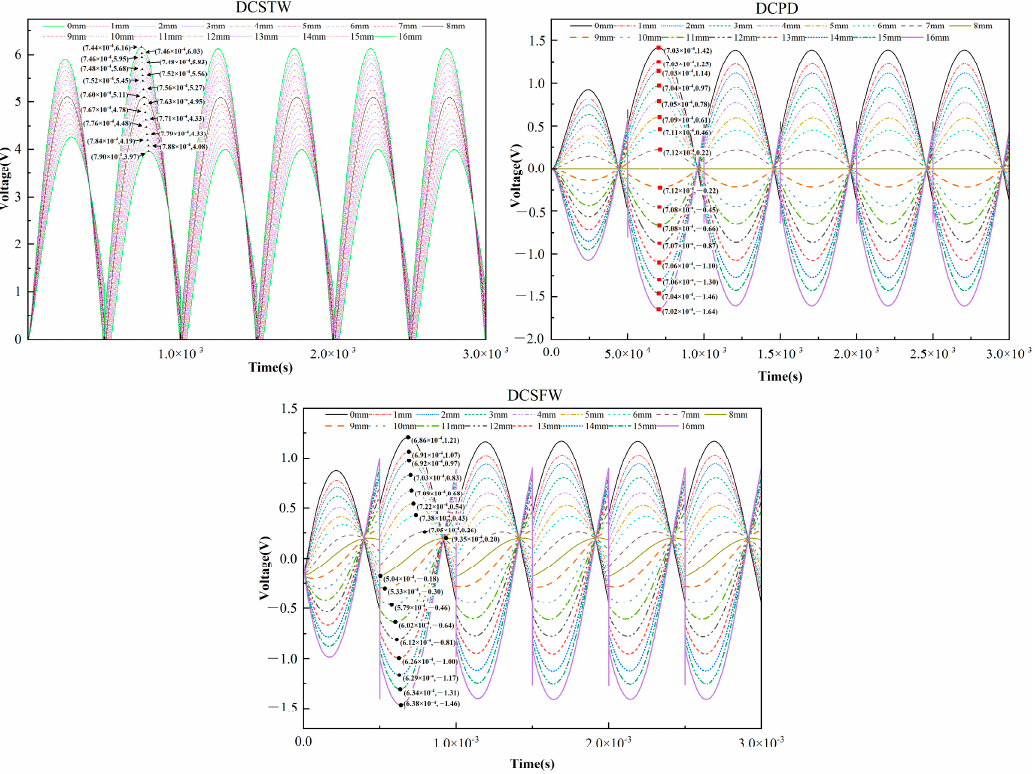
Figure 13. Comparison of the output signal of AD630 circuit under three excitation methods (before filtering).